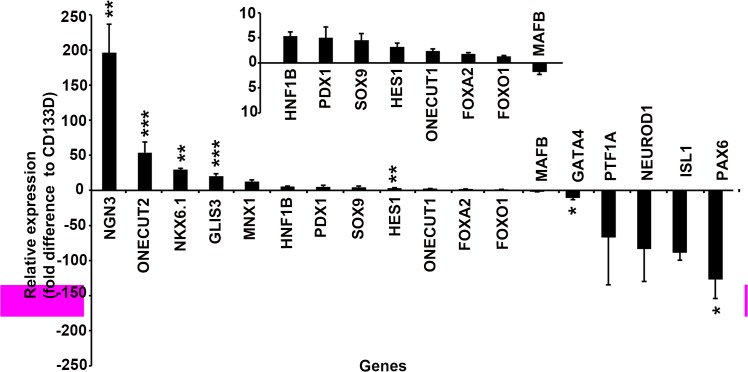
Relative mRNA expression of pancreas development transcription factors by CD133+ cells isolated after 4 days of exocrine tissue culture.Mean ± SEM relative expression level of genes in CD133+ cells compared to the CD133-depleted (CD133D) population shown on Y-axis as fold difference. Significance determined by Student’s t-test from 2-Δct values. ***, p<0.001, **, p<0.01, *, p<0.05 (n = 4 exocrine cultures). Genes ranked in order of overexpression in the CD133+ population. Inset shows gene expression using an enlarged scale. Genes are: Neurogenin 3 (NGN3), One cut homeobox 2 (ONECUT2), NK6 homeobox 1 (NKX6.1), GLIS family zinc finger 3 (GLIS3), motor neuron and pancreas homeobox 1 (MNX1), HNF1 homeobox B (HNF1B), pancreatic and duodenal homeobox 1 (PDX1), SRY (sex determining region Y)-box 9 (SOX9), Hairy enhancer of split 1 (HES1), One cut homeobox 1 (ONECUT1), Forkhead box A2 (FOXA2), Forkhead box O1 (FOXO1), v-maf avian musculoaponeurotic fibrosarcoma oncogene family, protein B (MAFB), GATA binding protein 4 (GATA4), Pancreas specific transcription factor 1A (PTF1A), Neuronal differentiation 1 (NEUROD1), ISL LIM homeobox 1 (ISL1), paired box 6 (PAX6). No expression of NK2 homeobox 2 or paired box 4 was detected.